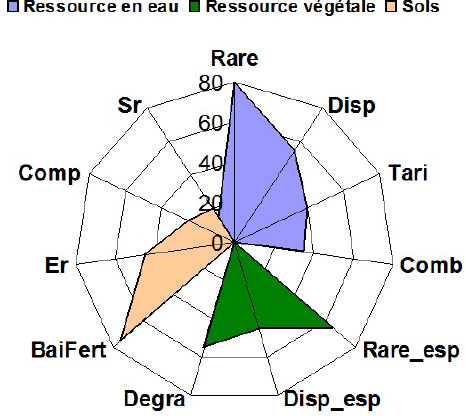
Figure 2. Causes du déboisement et de la sécheresse se- lon les populations locales. Légende : Agri = production agri- cole; Apas = activité pastorale; Eforet = exploitations forestières; Cdieux = Colère des dieux; Fchal = Forte chaleur; Fvege = feux de végétation; Vnaclim = variabilité naturelle du climat; De- bois = Déboisement; Sech = sécheresse.